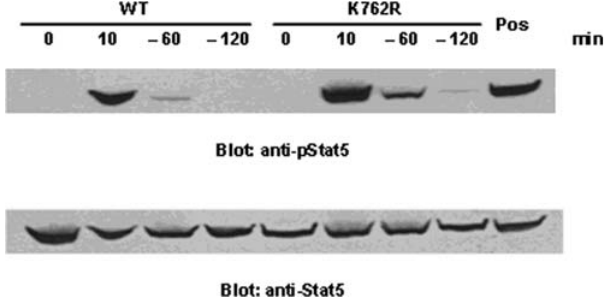
Figure 4. Prolonged G-CSF-induced Stat5 activation in K762R/ G-CSFR transfectants. BaF3 cells stably transfected with either the WT G-CSFR or K762R/G-CSFR were washed and incubated in cytokine- free media (RPMI/0.1%BSA) at 37 u C for 4 hrs. Cells were then treated with G-CSF (100 ng/ml) at 37 u C for 10 min, washed, incubated in media depleted of growth factors for the indicated times, and lysed. Proteins from whole cell lysates were separated on SDS-PAGE and transferred onto nitrocellulose membranes, which were blotted with anti-phospho- Stat5 antibody (upper panel). The blot was stripped and re-blotted with anti-Stat5 antibody to confirm equal protein loading (lower panel). Cells stimulated with activated orthovanadate at room temperature for 20 min are shown as a positive control.